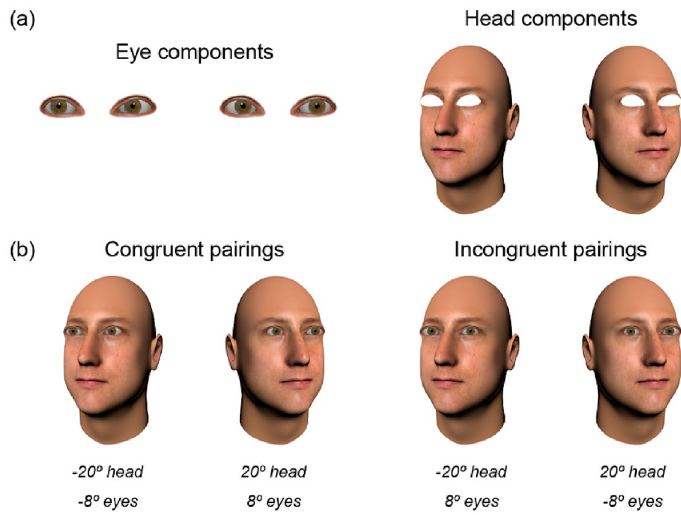
Figure 2. Wollaston stimuli. ( a ) Eyes isolated from a frontal head were paired with heads angled either left or right. ( b ) Congruent pairings (e.g., leftwards-angled eyes in leftwards-angled head) tended to produce a sense of averted gaze. Incongruent pairings (e.g., leftwards-angled eyes in a rightwards-angled head) tended to produce a sense of gaze directed towards the viewer. When comparing between the congruent and incongruent pairings, the stimuli are comprised of identical base components, but presented in different combinations. Hence, features like iris position, visible sclera and head rotation cues are controlled across this comparison, despite the differences in perceived direction of gaze. The face images were generated with FaceGen Modeller 3.5., (https:// faceg en.